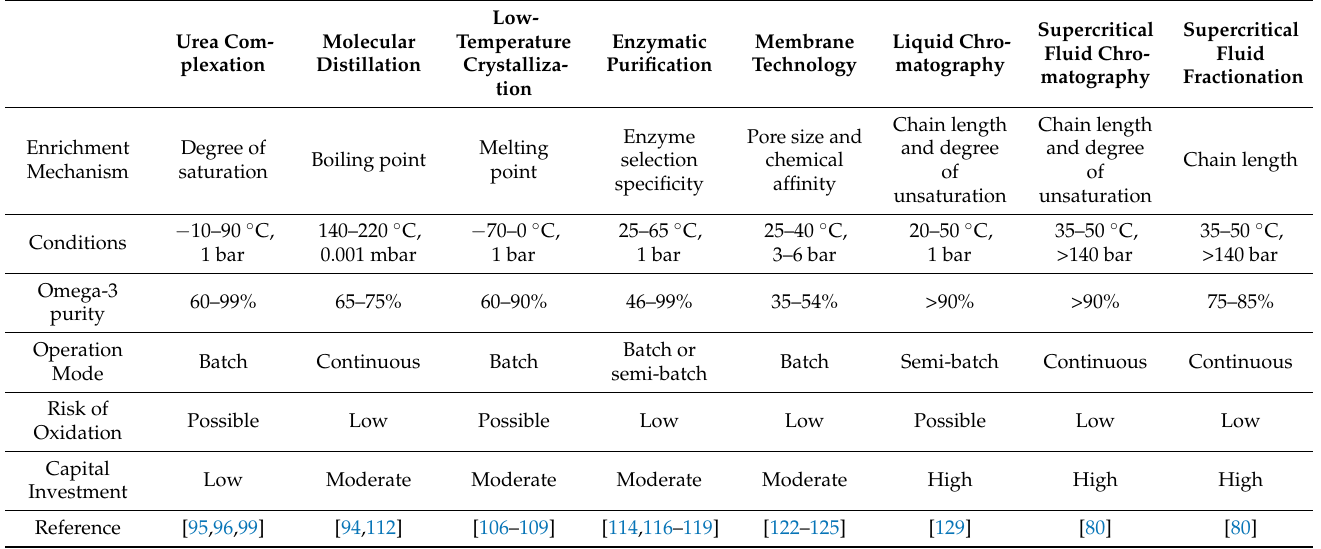
Table 5. Comparison of different concentration